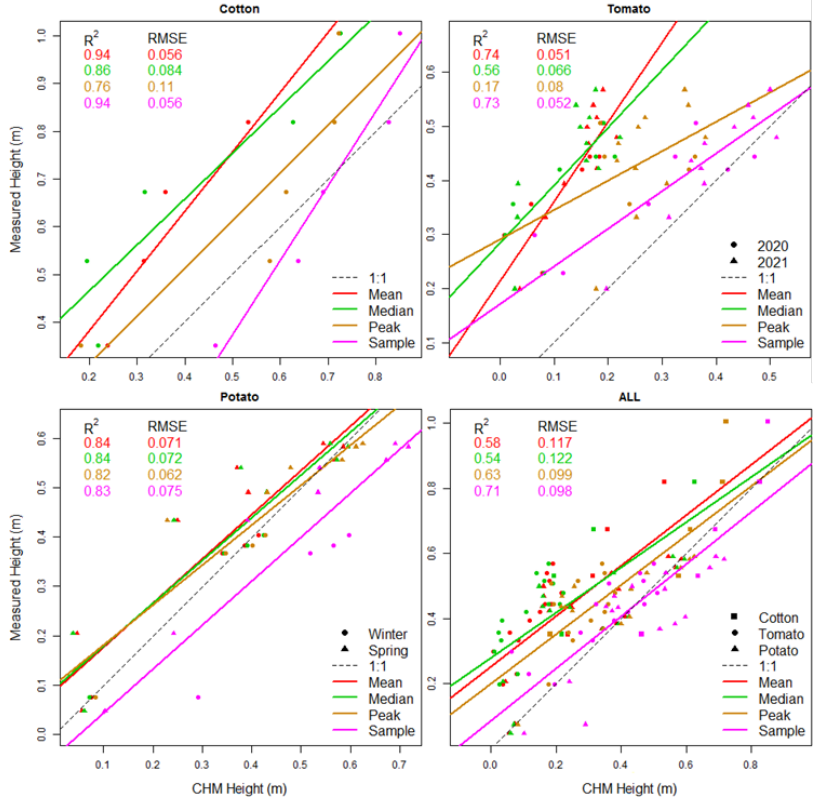
Figure 6. Linear regressions between the crop height models (CHMs) and manual height measure- ments.